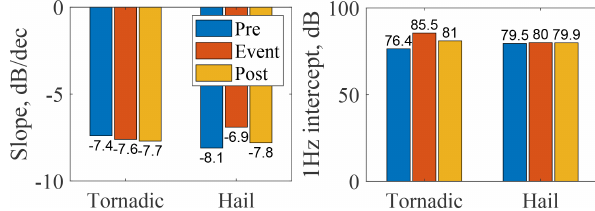
Figure 11. Linear fit